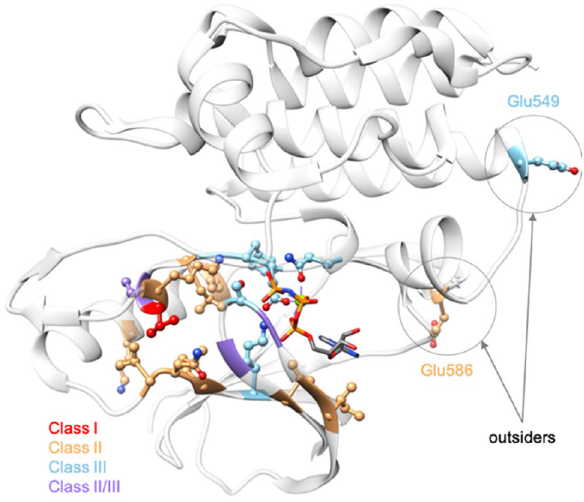
Figure 3. Mapping classes of known mutations in the kinase domain. The residues whose mutation leads to a known mutation class are represented in ball and stick. The one for which the mutation leads to the class I is colored in red, those leading to class II and class III are colored in orange and blue, respectively. The sites of mutations that can be a class II or III depending on the variant are colored in purple. The BRAF kinase is represented in light gray and transparent ribbons to facilitate the visualization (pdb code: 6pp9) 12 .